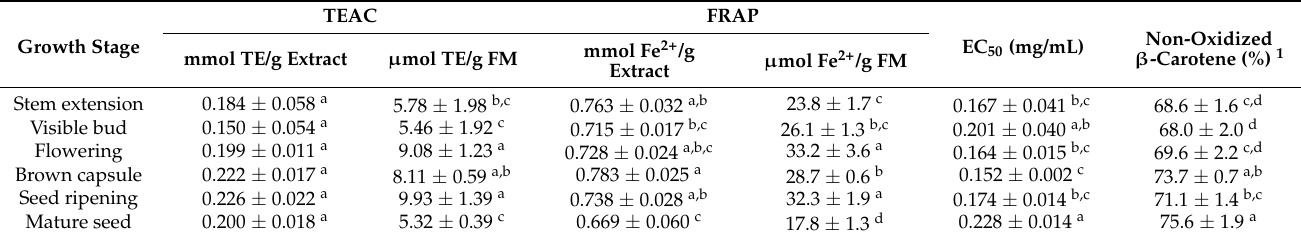
Table 5. Trolox equivalent antioxidant capacity (TEAC), ferric-reducing antioxidant power (FRAP), DPPH • scavenging activity (expressed as EC 50 ), and antioxidant activity in a β -carotene-linoleic acid emulsion system of flax harvested at different growth stages.